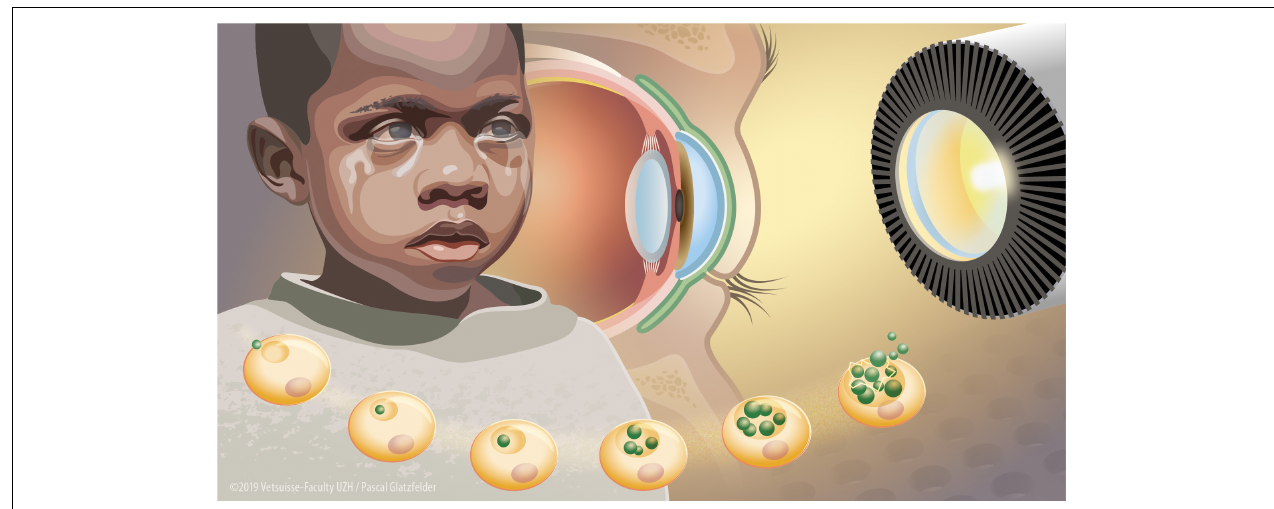
FIGURE 1 | Water-filtered infrared-A and visible light irradiation (wIRA/VIS) as a potential future treatment device to combat blinding trachoma. Blinding trachoma is a neglected tropical disease present in Sub-Saharan Africa, in particular affecting children. It is caused by recurrent infections of the conjunctival epithelium by C. trachomatis leading to fibrosis and scarring of the conjunctiva, ocular discharge, trichiasis, and corneal opacity with blindness (left aspect of the figure). C. trachomatis is an obligate intracellular bacterium with a complex life cycle including the attachment of an elementary body (EB) to an epithelial cell, forming an intracytoplasmic inclusion with differentiation into reticulate bodies and multiplication by binary fission and finally lysis of the inclusion with the release of EBs (bottom aspect of the figure). wIRA/VIS irradiation produced by radiation of a halogen bulb, filtered through a water-filled cuvette in special irradiators (right aspect of the figure) could reduce chlamydial burden in vitro by affecting mature inclusions and as well as by reducing infectious EB load. Future in vivo wIRA/VIS treatment of trachoma patients would be applied by irradiation of the C. trachomatis -infected conjunctiva (in green) through a closed eyelid reaching the infected part (inner conjunctival lining) without harming the inner structures of the eye such as the cornea, the vitreous body or the retina (central aspect of the